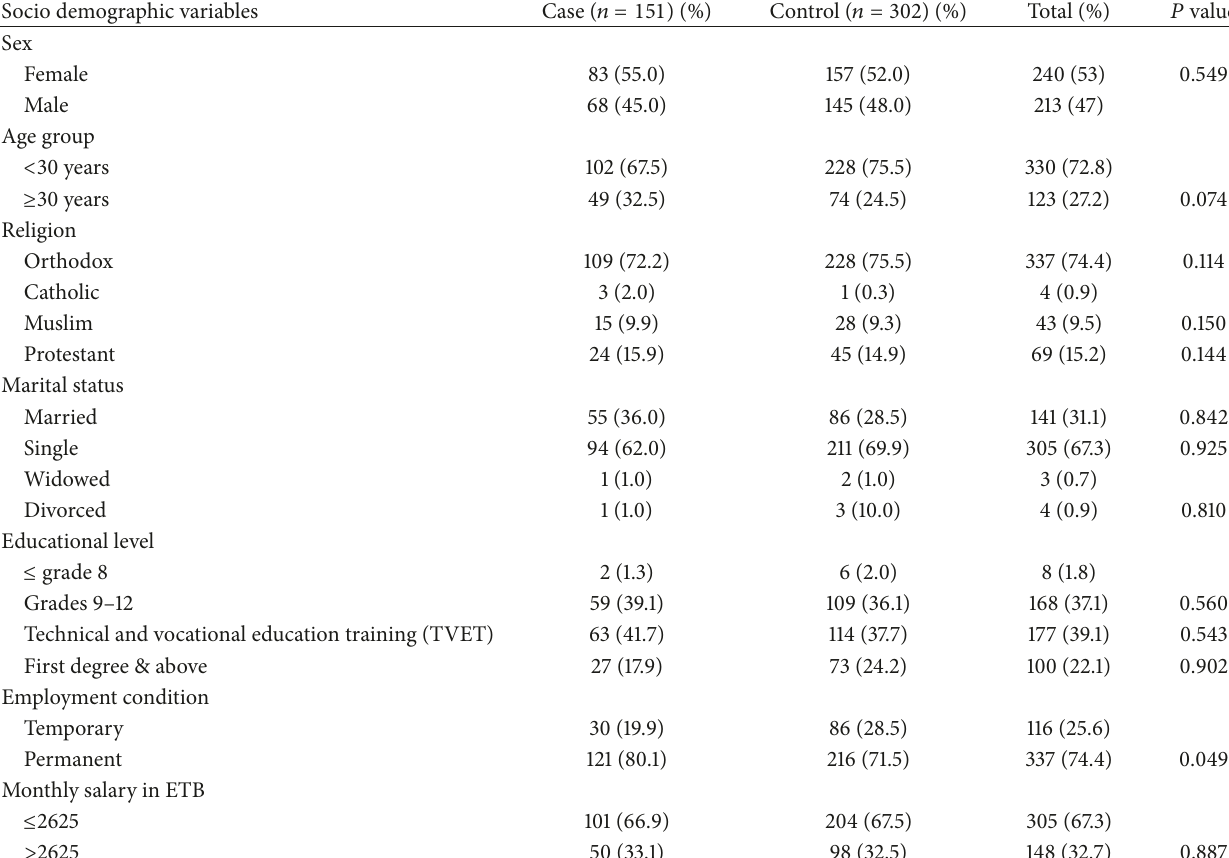
Table 1: Distribution of sociodemographic characteristics of participants in pharmaceutical factories in Addis Ababa, Ethiopia, May